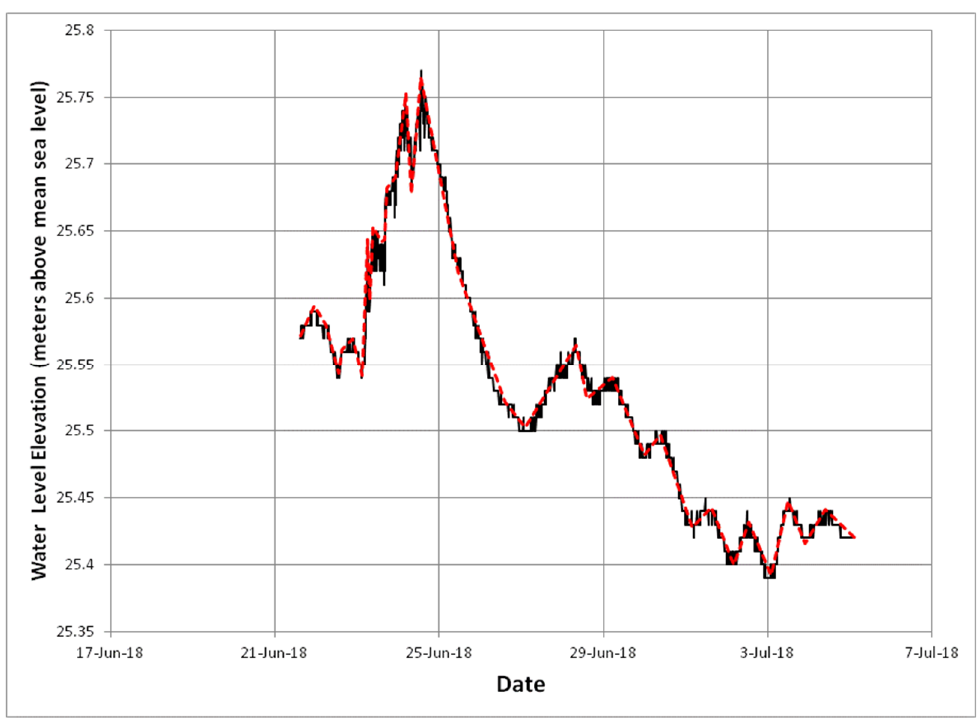
Figure 5. Complete hydrograph from sensors (black, continuous line) and simplified hydrograph considered (red, dashed line).